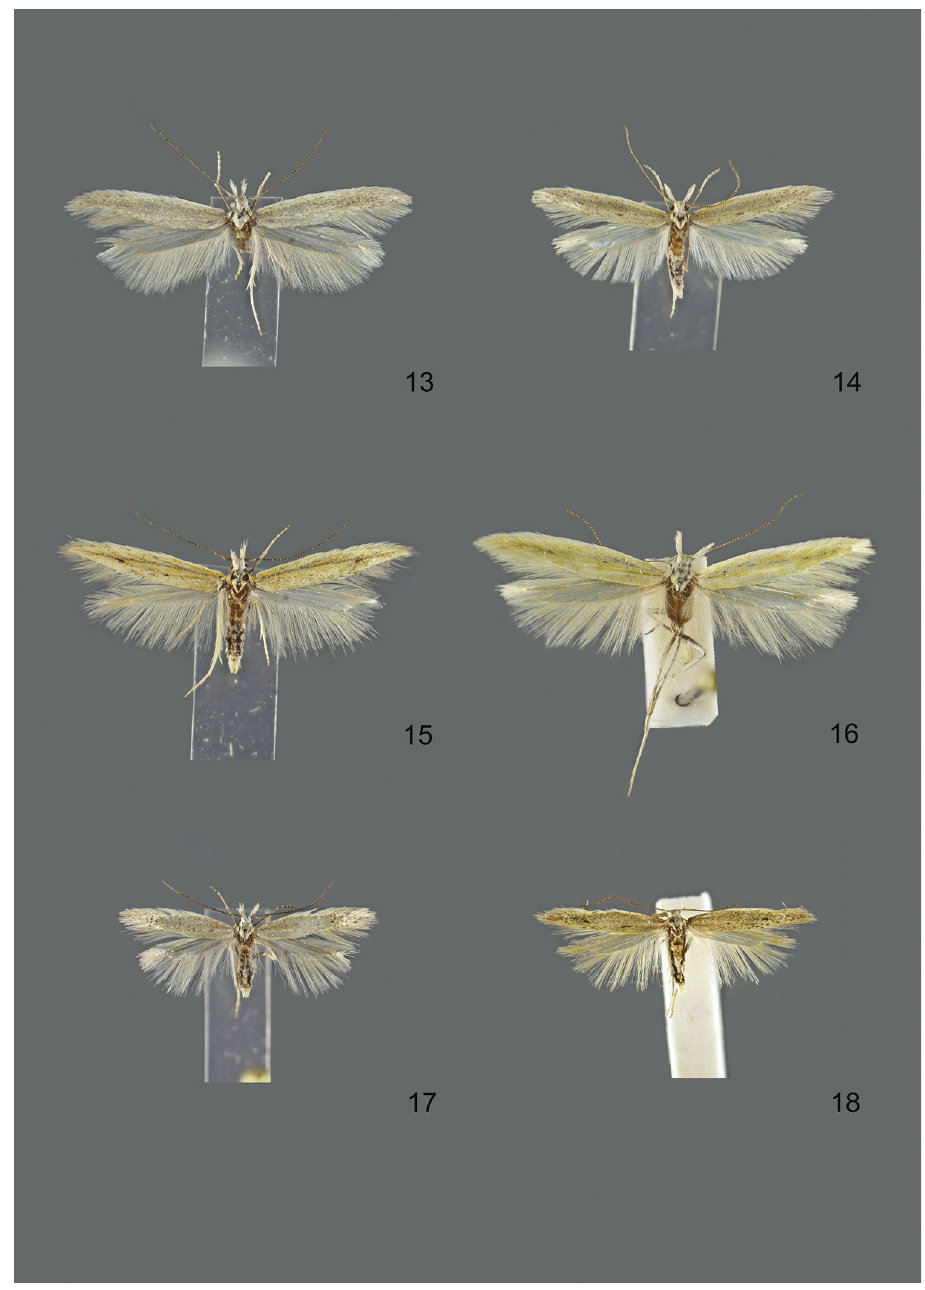
Figures 13–18. Megacraspedus adults in dorsal view. 13 M. lanceolellus (Zeller, 1850) – male, Spain (TLMF) 14 M. lanceolellus (Zeller, 1850) – male, Spain (TLMF) 15 M. lanceolellus (Zeller, 1850) – male, Spain (ZMUC) 16 M. lanceolellus (Zeller, 1850) – male, Spain (ZMUC) 17 M. bengtssoni sp. n. – Holo- type, male, Spain (ZMUC) 18 M. bengtssoni sp. n. – Paratype, male, Spain